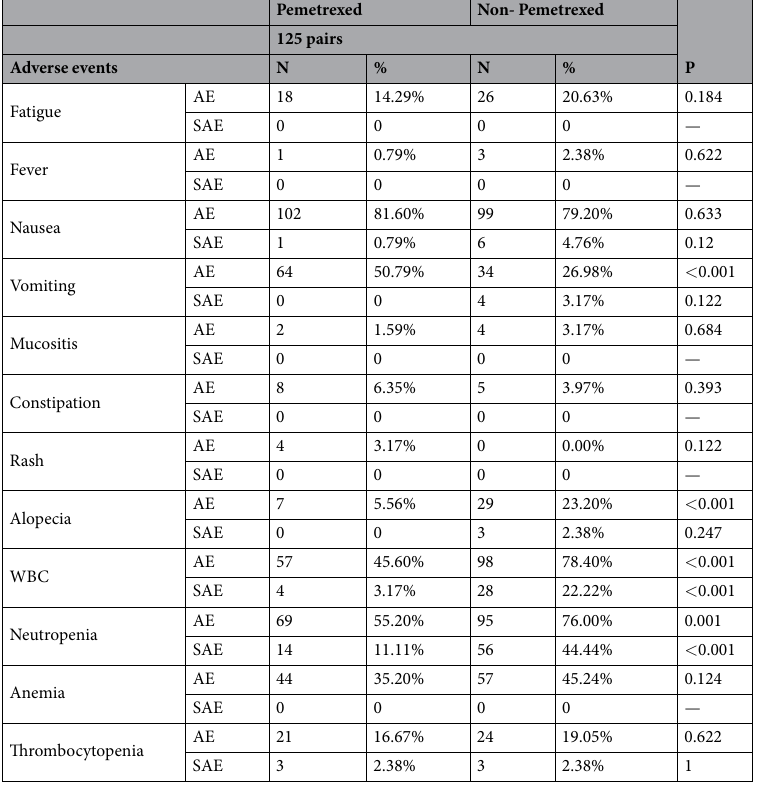
Table 5. Comparing incidences of toxic effects between the propensity score matched treatment group. AE, adverse event SAE, sever adverse